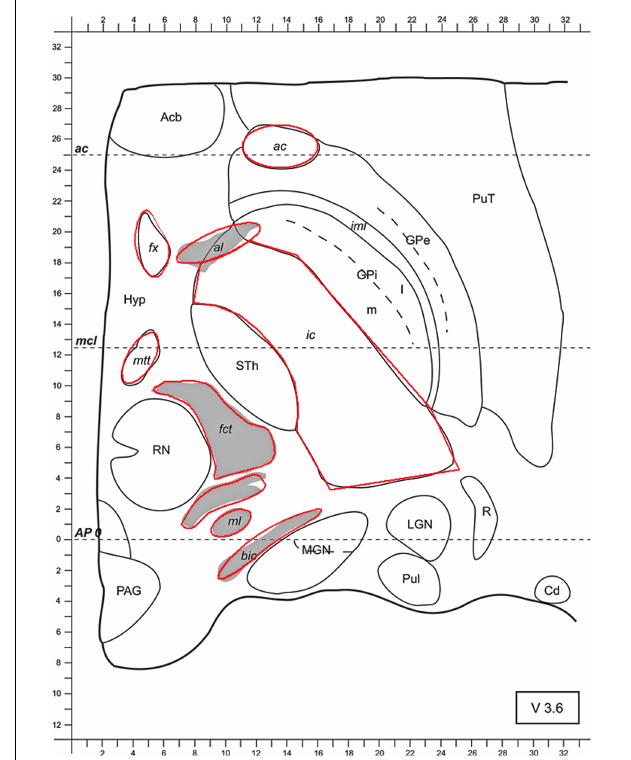
FIGURE 1 | Axial slice from the stereotactic atlas of Morel 3.6 mm ventrally to the AC-PC-level (anterior commissure-posterior commissure). At approximately similar levels in patients the STN can be targeted along a parallel line to the x -axis at the anterior border of the RN. Conductivity values were set to 1.0 S/m for ac, fx, al, ic, mtt, fct, and ml. Bic was attributed with a conductivity of 0.1 S/m, whereas gray matter was attributed with a conductivity of 0.2 S/m. Abbreviations: anterior commissure (ac), fornix (fx), ansa lenticularis (al), internal capsule (ic), mammillothalamic tract (mtt), fasciculus cerebello-thalamicus (fct), medial lemniscus (ml), brachium of the inferior colliculus (bic), medial and lateral geniculate nucleus (MGN and LGN, respectively), pulvinar (Pul), reticular thalamic nucleus (R), globus pallidus internus and externus (GPi and GPe, respectively), putamen (Put), nucleus accumbens (Acb), hypothalamus (Hyp), subthalamic nucleus (STh; the subthalamic nucleus is abbreviated with Sth, whereas the abbreviation STN is more commonly used), red nucleus (RN), periaqueductal (or central) gray (PAG), caudate nucleus